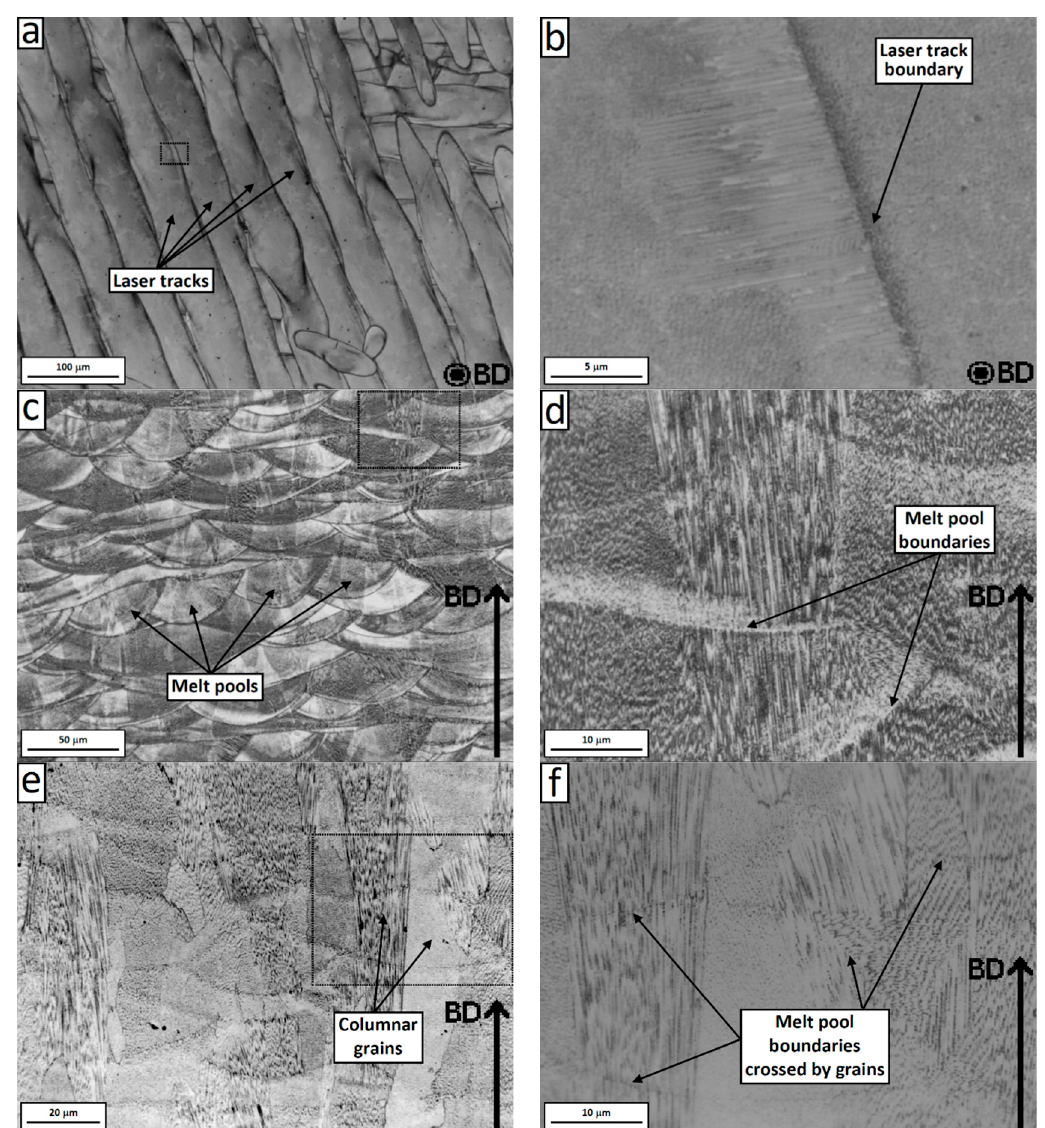
Figure 4. Optical Microscope (OM) micrographs of the electrochemically-etched SLM Inconel 718 on the horizontal plane with track–track MPBs and high magnification view ( a , b ), and vertical plane with arc-shape MPBs and high magnification view ( c , d ). OM micrographs of the Kalling solution etched Inconel 718 on the vertical plane showing columnar grains across several layers and high magnification view ( e , f ).